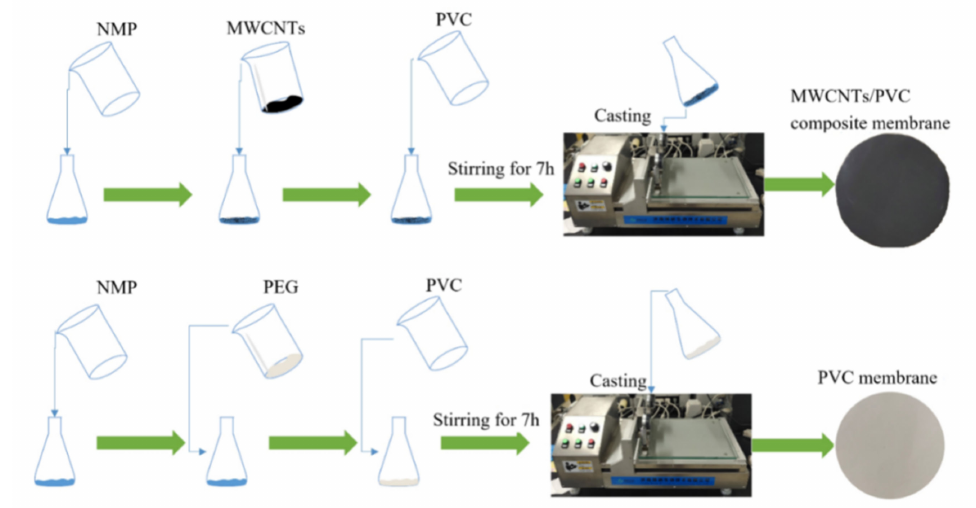
Figure 1. Schematic illustration of the synthesis of the different membranes.